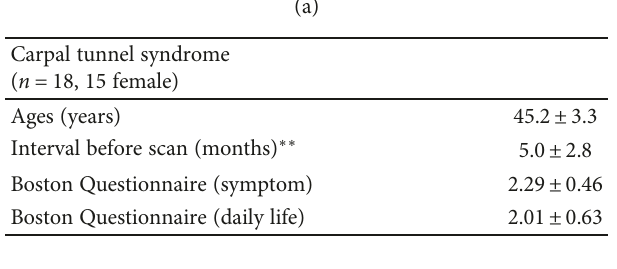
Table 1: Demography of subjects and clinical